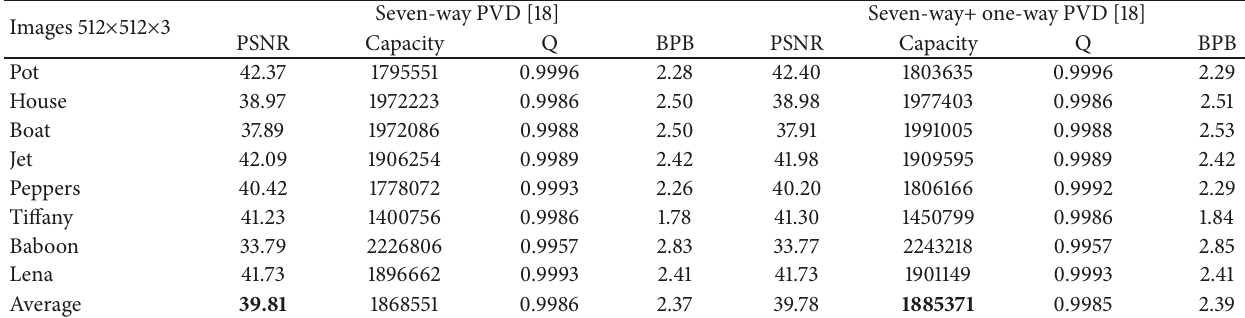
Table 3: Results of Pradhan et al.’s seven-way PVD technique [18].